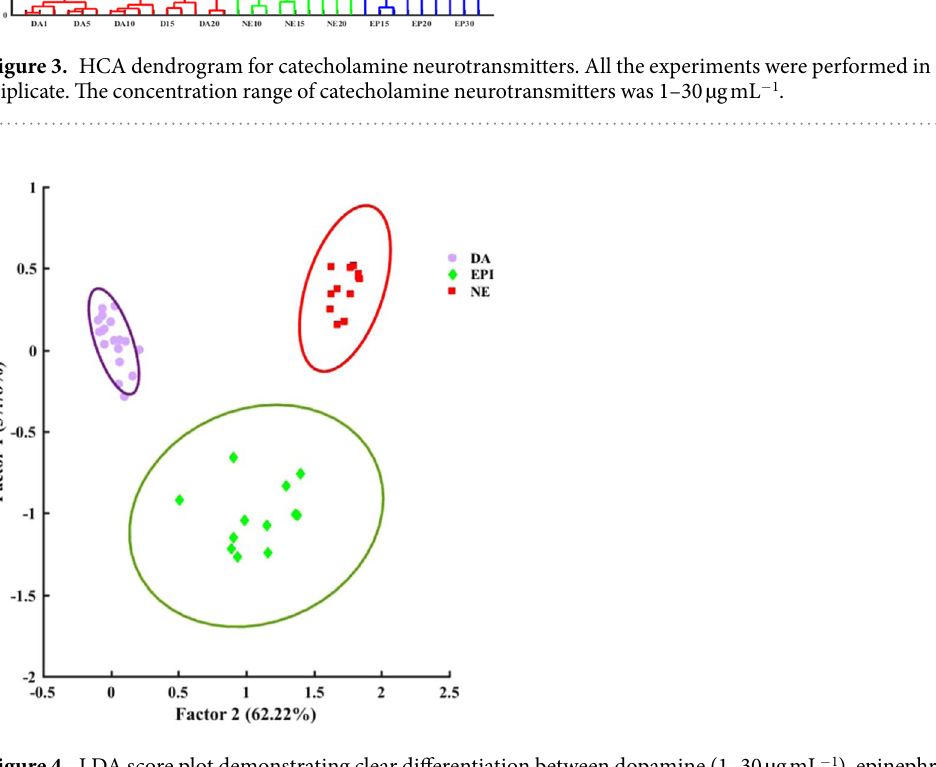
Figure 4. LDA score plot demonstrating clear differentiation between dopamine (1–30 µ g mL − 1 ), epinephrine (10–30 µ g mL − 1 ) and norepinephrine (10–30 µ g mL − 1